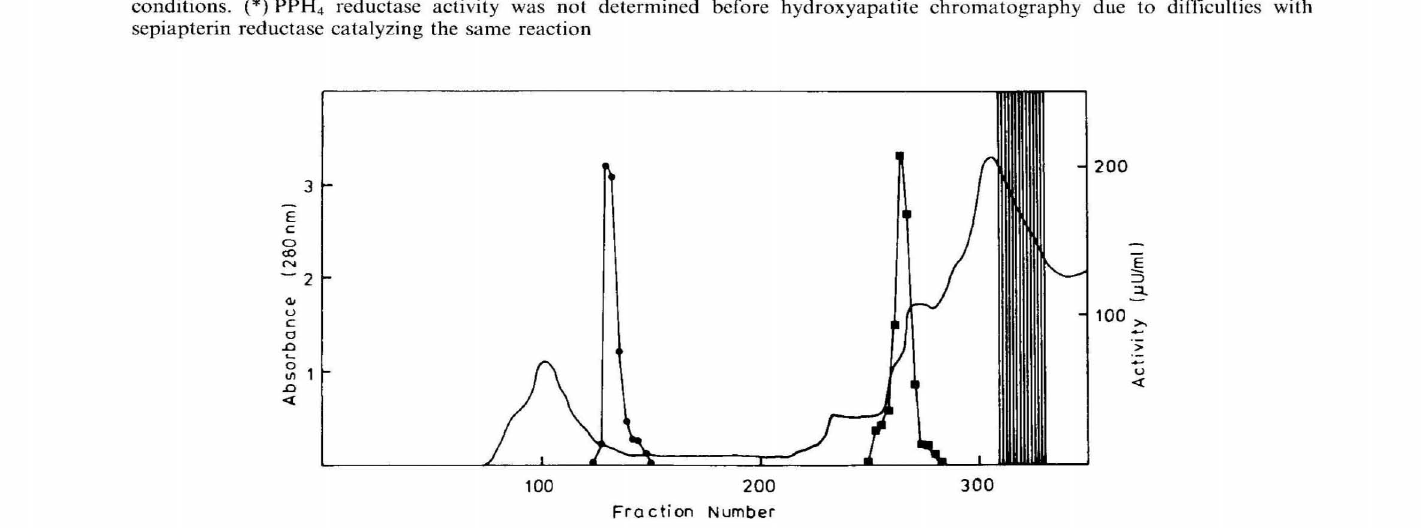
Figure 1. Elution profile of PPH 4 synthase, PPH 4 reductase and sepiapterin reductase from hydroxyapatite column. Pro tein concentration was measured by absorbance at 280 nm. (-e-e-) PPH 4 synthase activity was determined as dcscribed (14). (-.-.-) PPH 4 reductase activity was measured under standard assay conditions. (Striped zone) sepiapterin reductase activity was evaluated qualitatively by the decolorization of sepiapterin (45). The gradient was started at fraction number 106 (9 ml/fraetion). End of the gradient was fraction number 375 (not shown) Pteridines ! Vol. 1 ! 1989 /